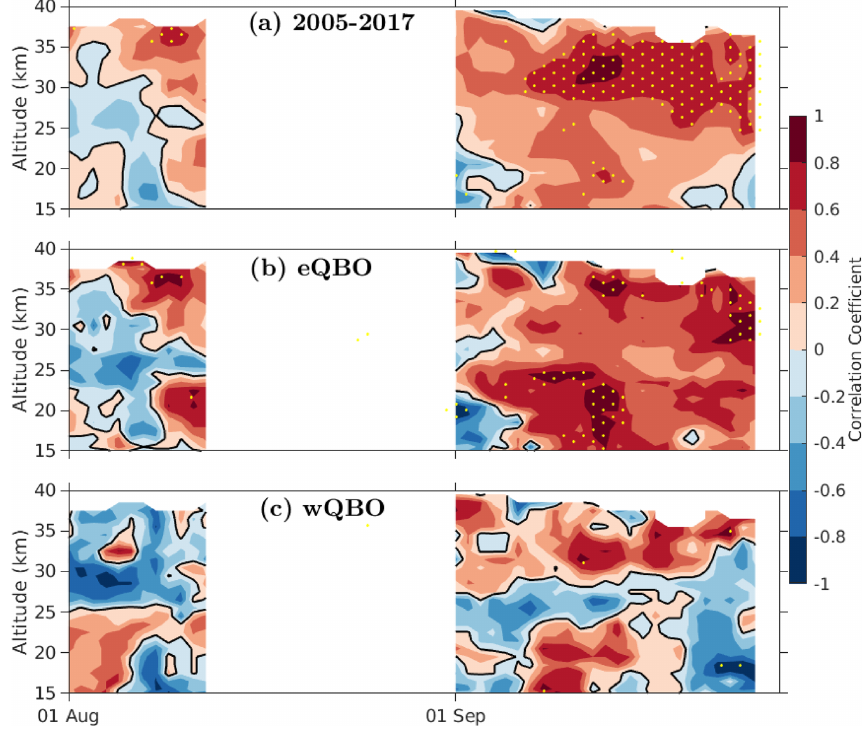
Figure 9. Correlation between (cid:99) Ap and area-weighted ACE-FTS ClONO 2 poleward of 60 ◦ S for (a) all years, (b) eQBO years, and (c) wQBO years. The y axis is the altitude from 15 to 40km, and the x axis is the time from 1 August to the end of September. The coloured contours show the correlation coefficient with a contour interval of 0.2, and the black line shows the zero contour. Stippling indicates statistical